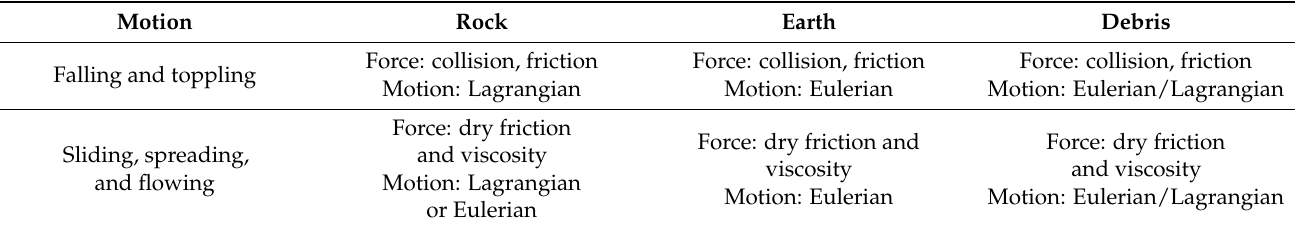
Table 4. Relationship between models and